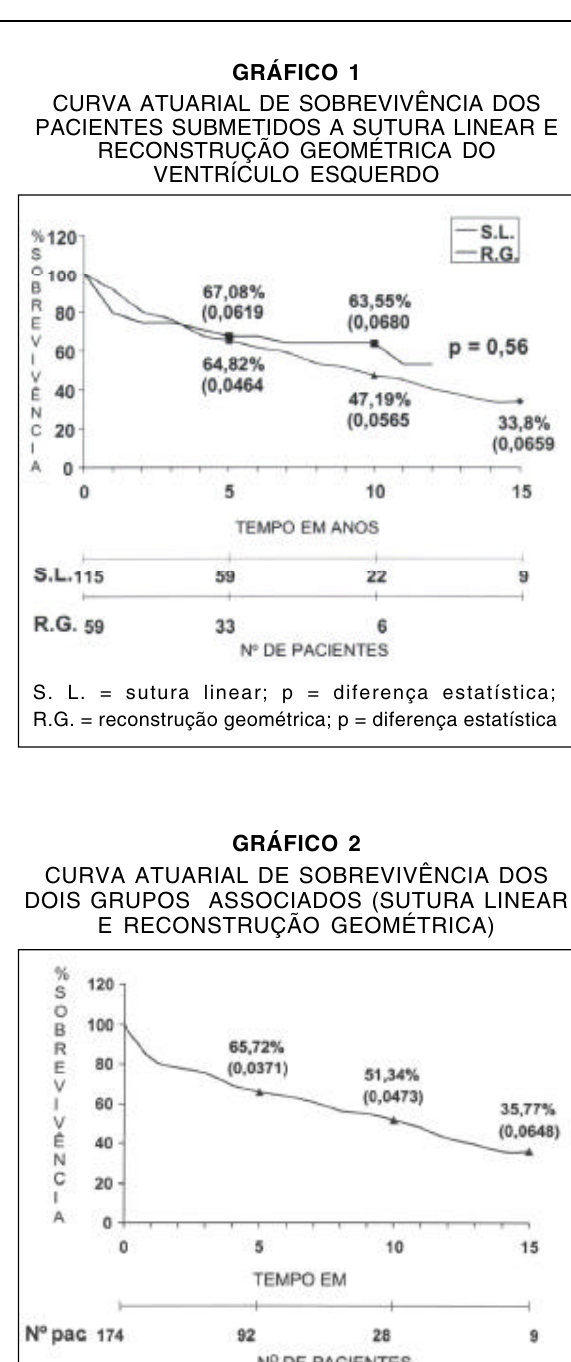
Fig. 2 – Correção do aneurisma de VE (apical) com utilização do método de reconstrução. M = medidor de diâmetro para implante do anel